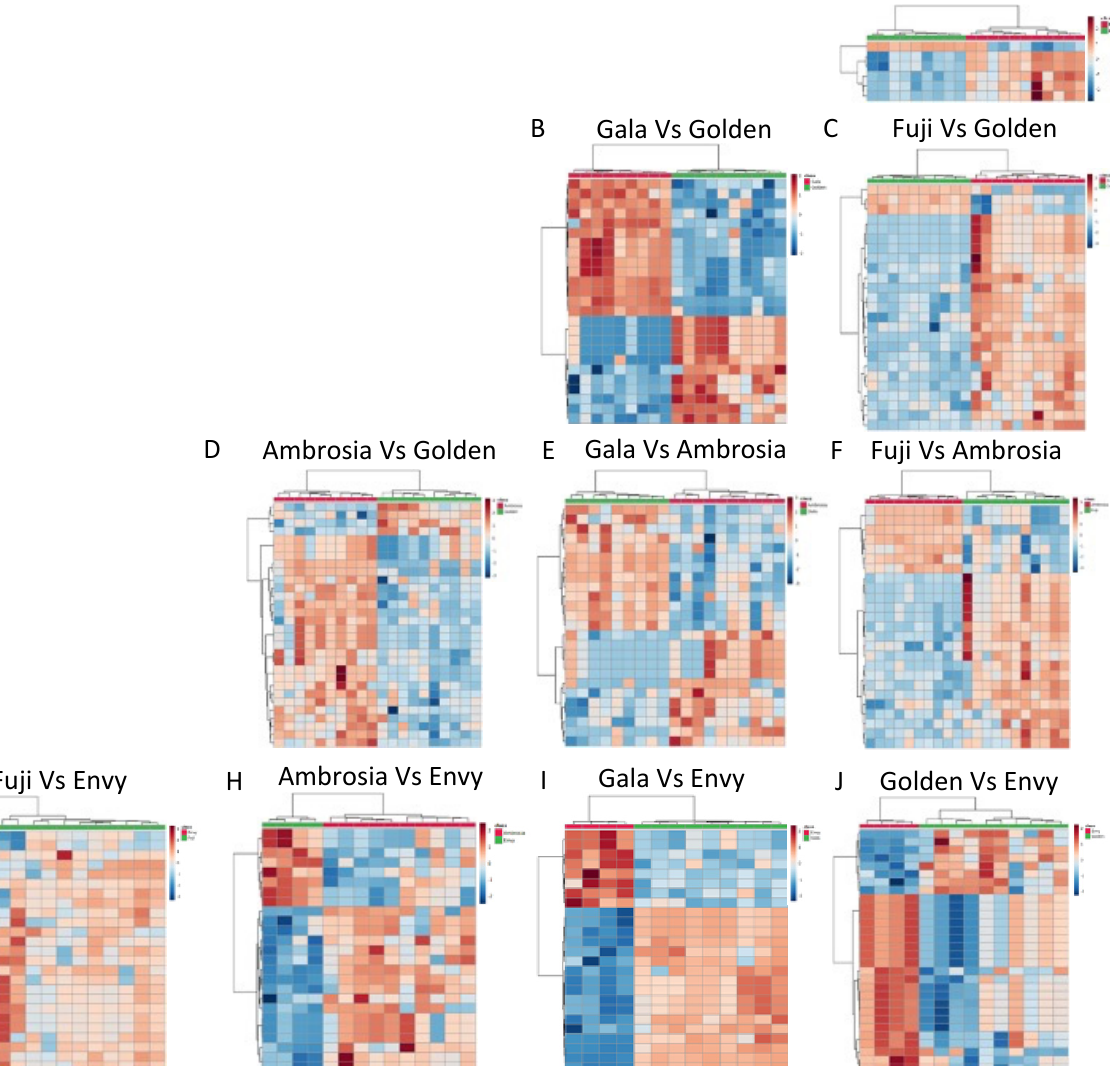
Figure 3. Hierarchical clustering heatmaps made using the top modulated molecules in the following comparisons: Fuji versus Gala ( A ), Gala versus Golden ( B ), Fuji versus Golden ( C ), Ambrosia versus Golden ( D ), Gala versus Ambrosia ( E ), Fuji versus Ambrosia ( F ), Golden versus Envy ( G ), Ambrosia versus Envy ( H ), Gala versus Envy ( I ), and Fuji versus Envy ( J